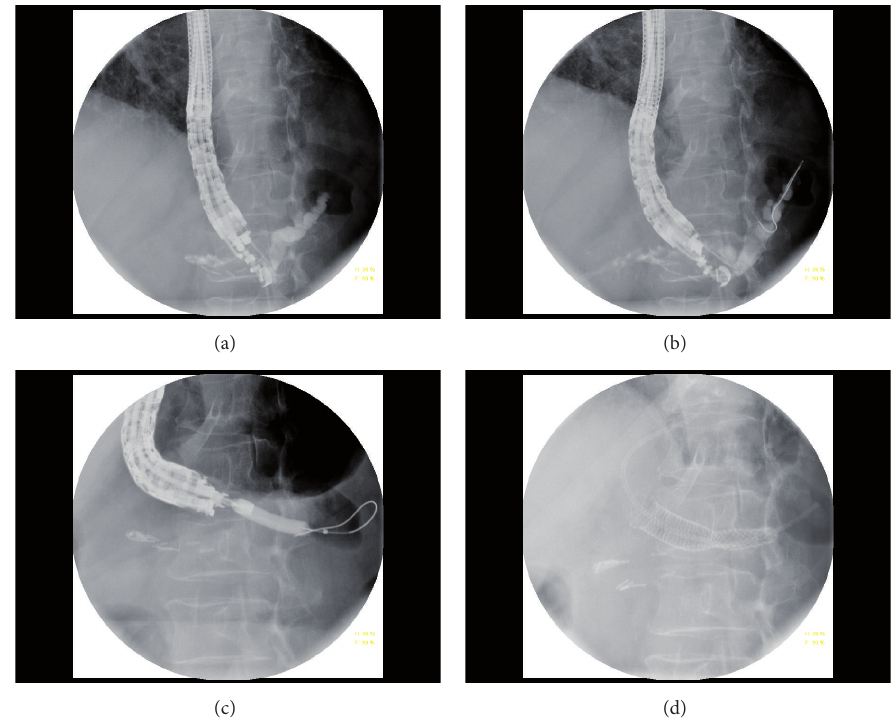
Figure 3: Transluminal stenting in a patient s/p central pancreatectomy with pancreaticogastrostomy obstruction. (a) Initial pancreatogram. (b) Passage of a 0.025 󸀠󸀠 guidewire. (c) Pancreaticogastrostomy tract dilation with 6 mm dilation balloon. (d) Placement of a 8 × 60mm fully covered SEMS followed by 7Fr × 7cm single-pigtail plastic stents